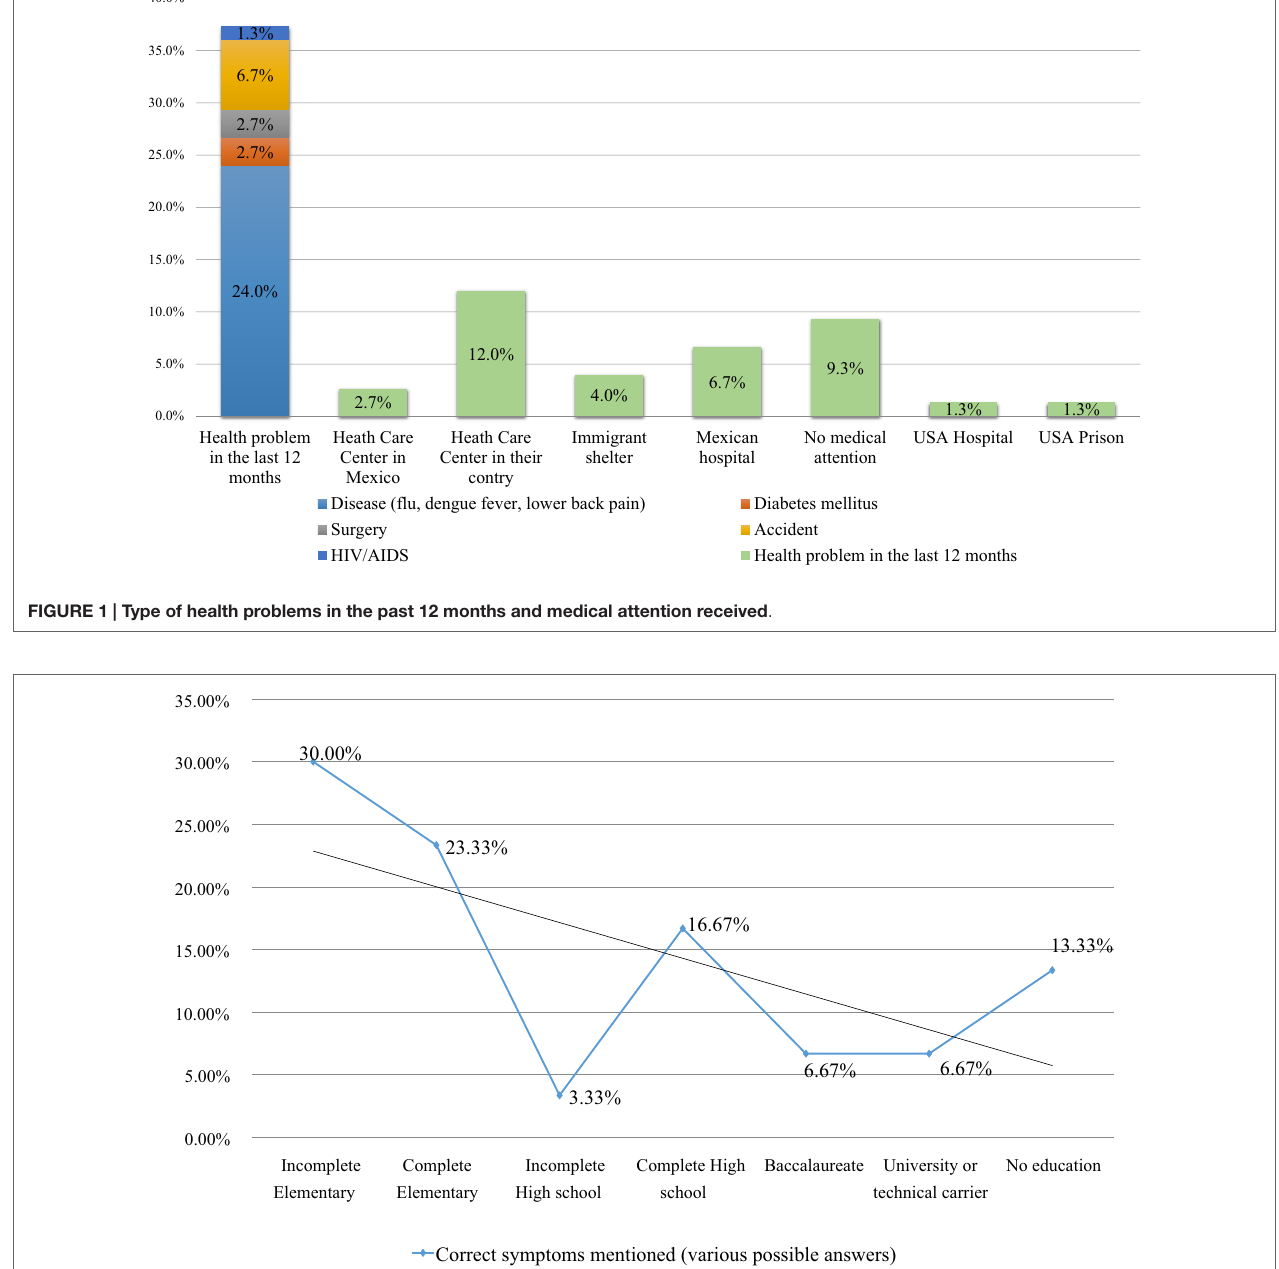
FigUre 2 | education level and TB symptoms knowledge .